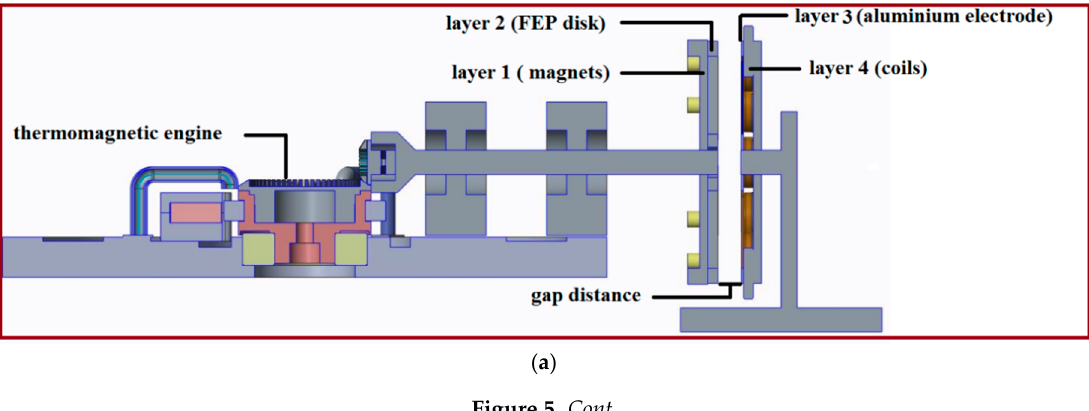
Figure 4. Schematic diagram of the working mechanism of the TENG based on the rotation of the FEP on the aluminum